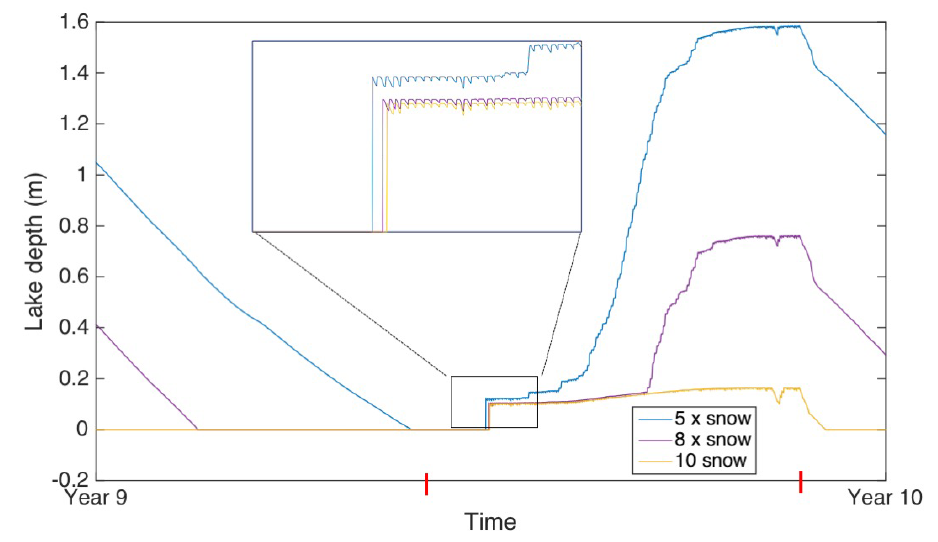
Figure 7. The evolution of lake depth of the final year of each of the simulations for 5, 8, and 10 times the reference case level of accumulation. The zoomed in area shows that the time of onset is different for each case. Red lines on the horizontal axis indicate the first and final occurrence of melt during this year. Table 2. Maximum and average lake depths for the final 5 years of simulations for the reference case and the cases of increased air tempera- tures of 0.5, 1, 1.5, and